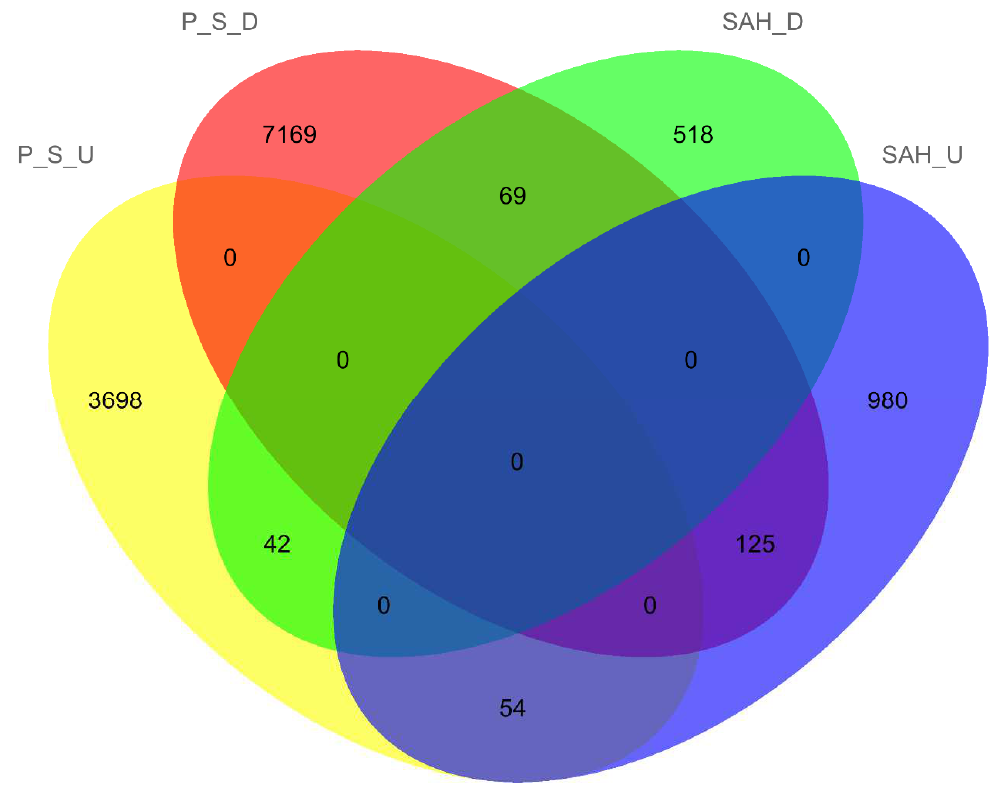
Figure 7. The Venn diagram of upregulated and downregulated DEGs in different treatments and different parts of G. dilepis . (P_S_U: upregulated DEGs in stipe compared with the pileus, P_S_D: downregulated DEGs in stipe compared with the pileus, SAH_U: upregulated DEGs in SAH group compared with the control group, SAH_D: downregulated DEGs in SAH group compared with the control group).